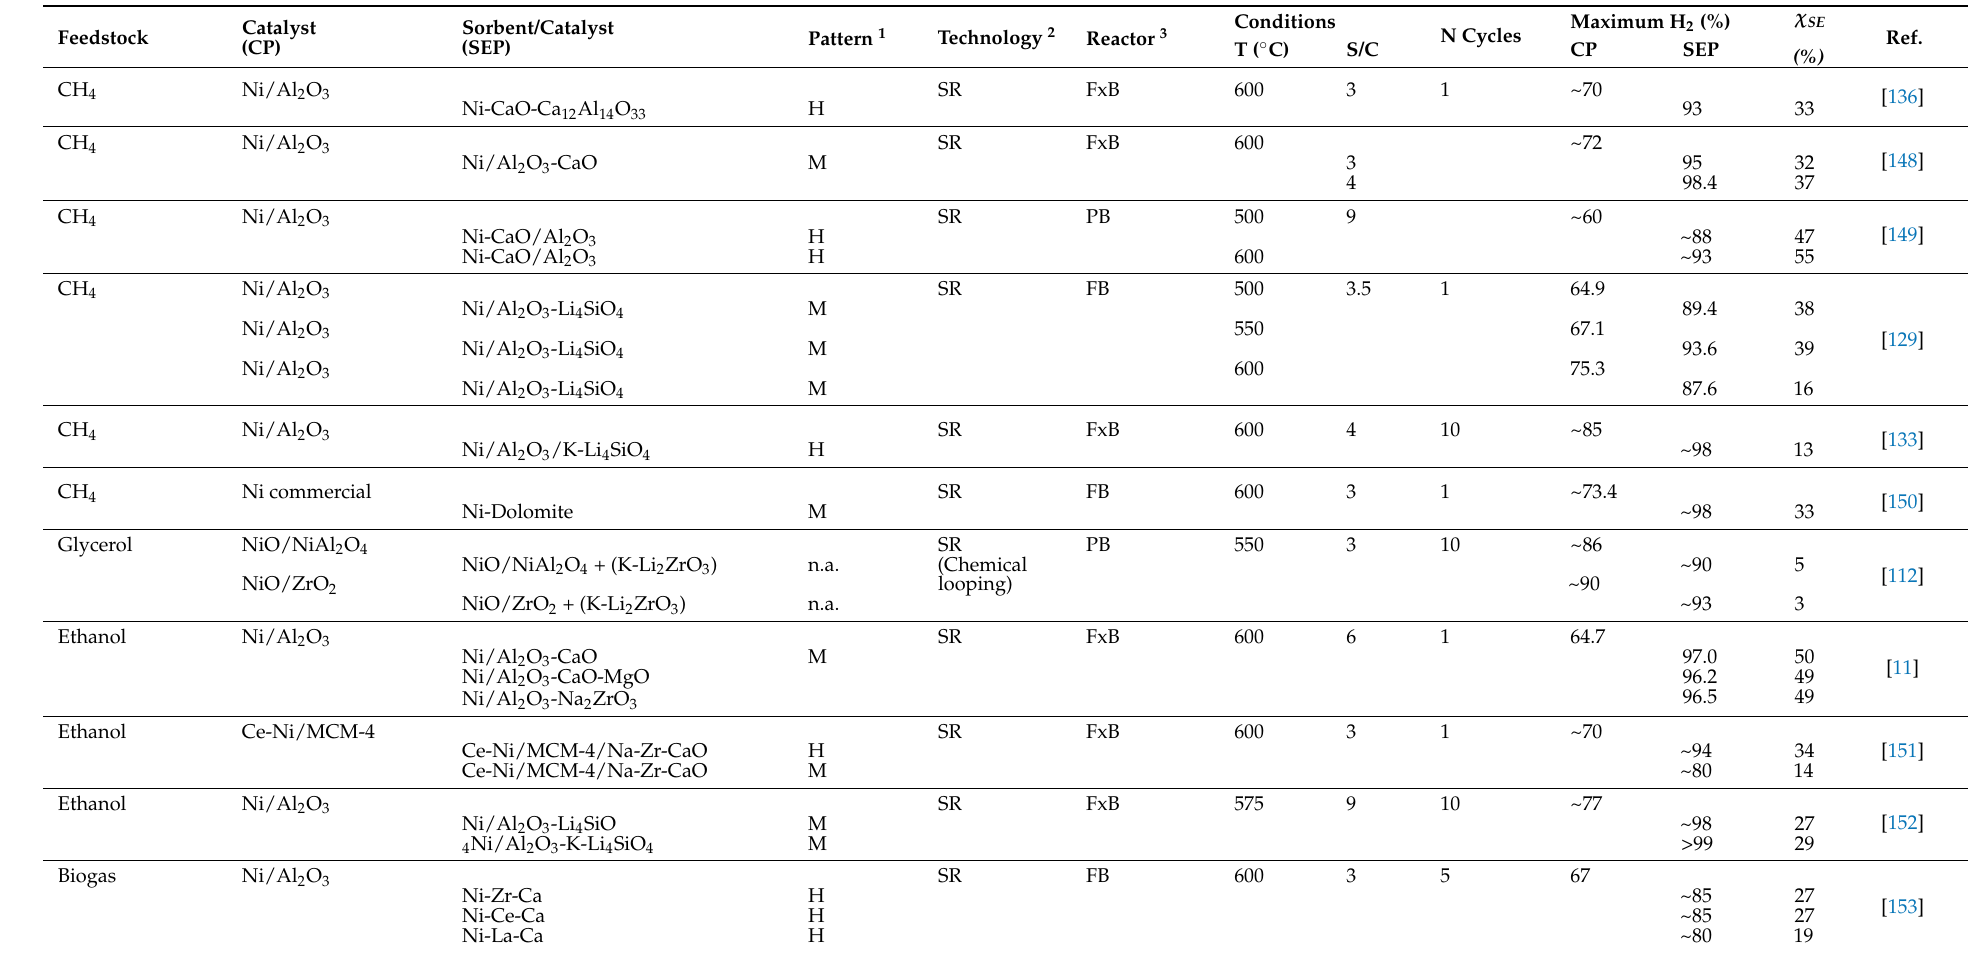
Table 7. Comparison of H 2 production using conventional and sorption-enhanced